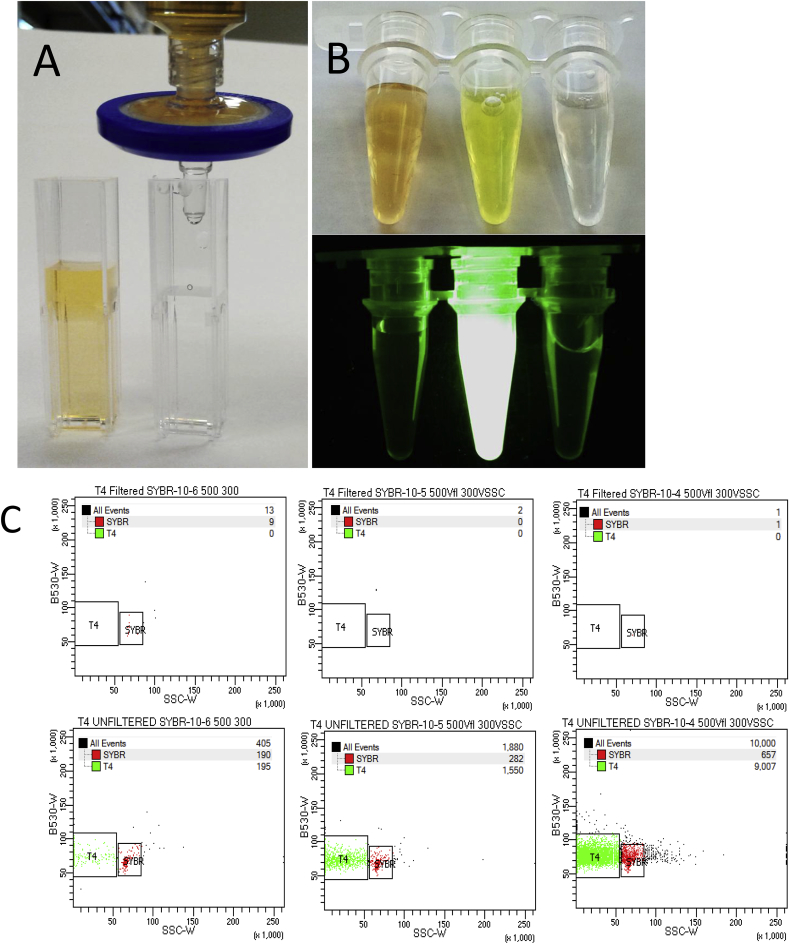
Removal of SYBR Green I from solution by coalescence on a membrane for aqueous solutions sterilization (EMD Millipore REF# s). 50x SYBR Green I in 1-kDa filtered 1x TE before (left) and after (right) filtration through 0.22 μm syringe filter.A Left to right: 25x unfiltered SYBR Green I in TE buffer; 25x unfiltered SYBR Green I and 150 ng μL−1 double stranded DNA in TE; 25x filtered SYBR Green I and 150 ng μL−1 double stranded DNA in TE. Visualised in natural light (top) and in UV (bottom).B Flow cytometric signal of bacteriophage T4 dilution series, stained with filtered (upper row) and unfiltered (lower row) SYBR Green I. (For interpretation of the references to colour in this figure legend, the reader is referred to the Web version of this article.)